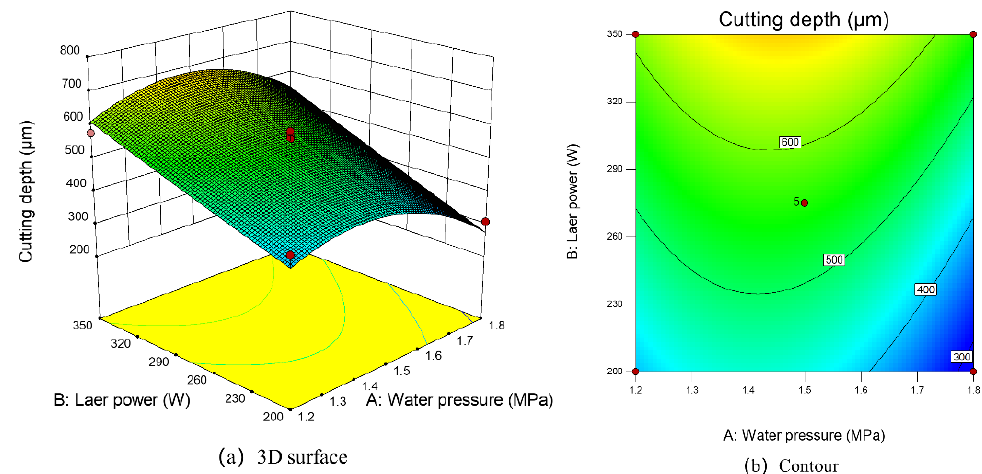
Figure 16. The 3D surface and contour map of the influence of laser power and water pressure on cutting depth.